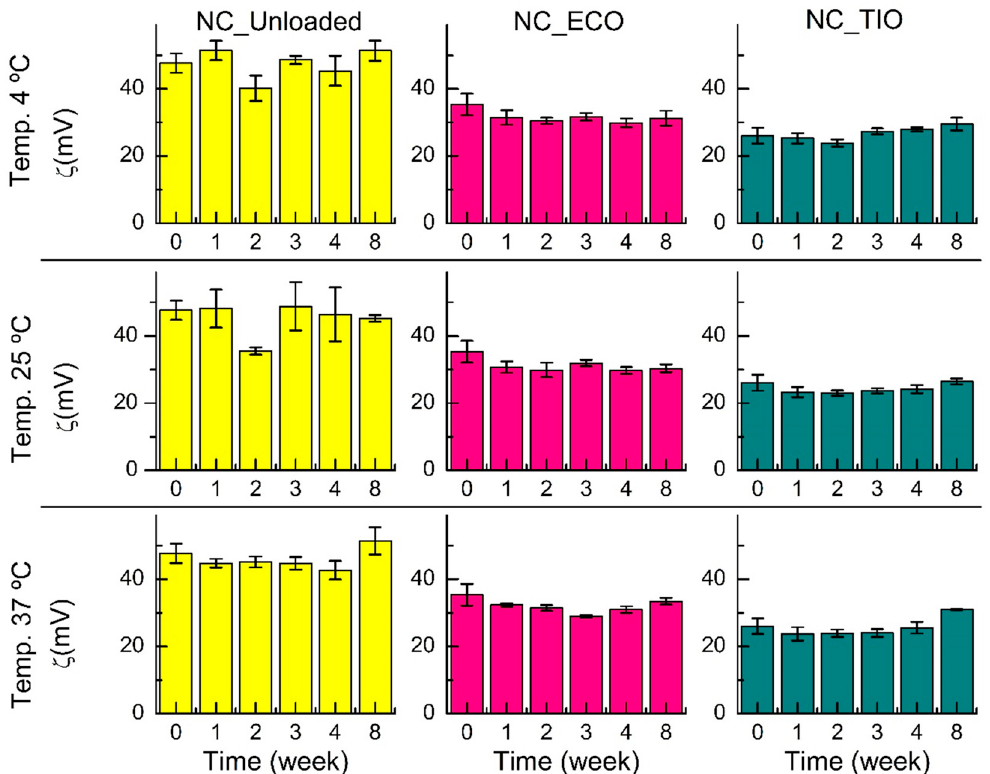
Figure 6. Evolution of the ζ potential over time of drug-loaded and unloaded (blank) NC incubated at 4, 25, and 37 °C. Data shown are means ± SD ( n = 3).